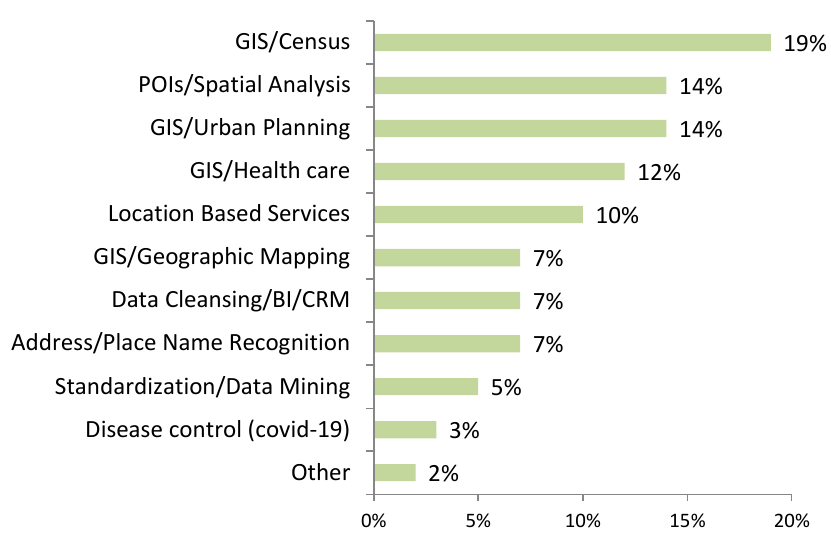
Figure 7. Keywords’ occurrences by application area (%).